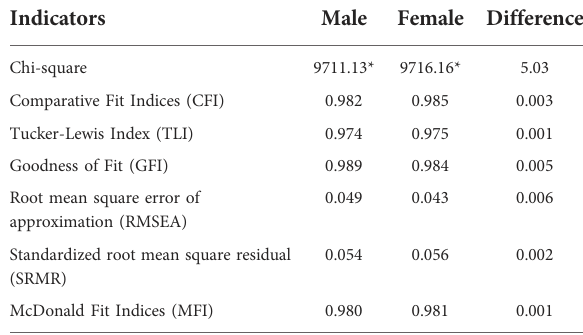
TABLE 5 Multiple indicators for measurement invariance for